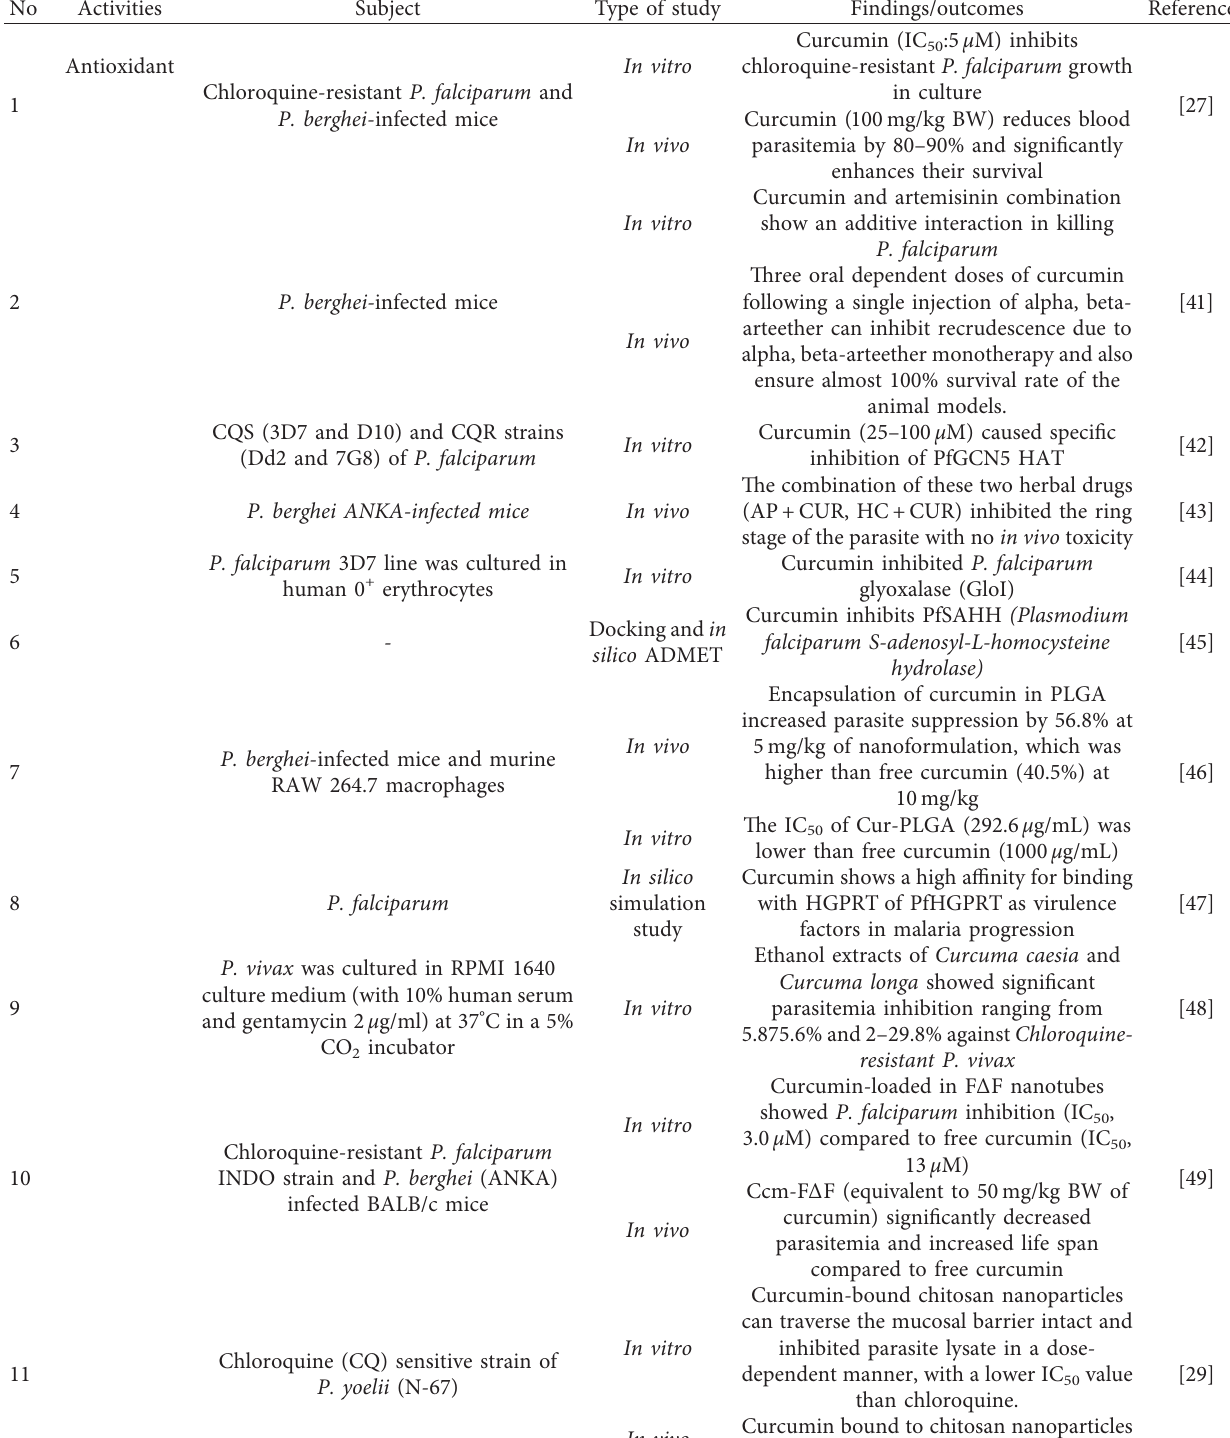
Table 1: Several studies related to curcumin as an